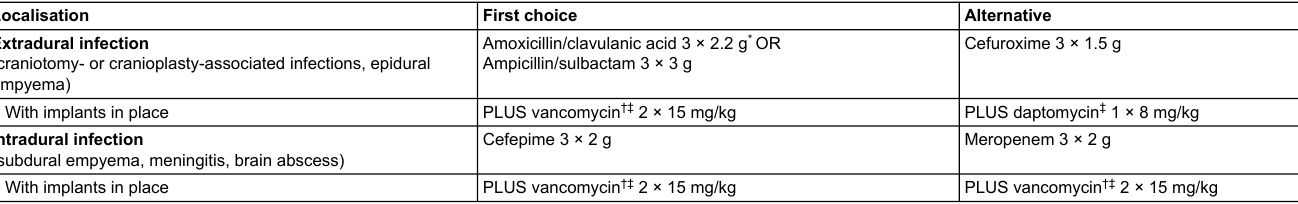
Table 2: Empirical intravenous treatment for intra- and extradural infections (local susceptibility data and patient’s renal function and body weight must be taken into account). Localisation